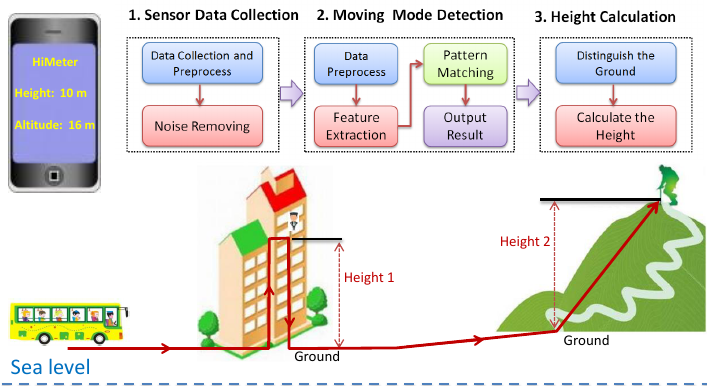
Figure 1. Overview of